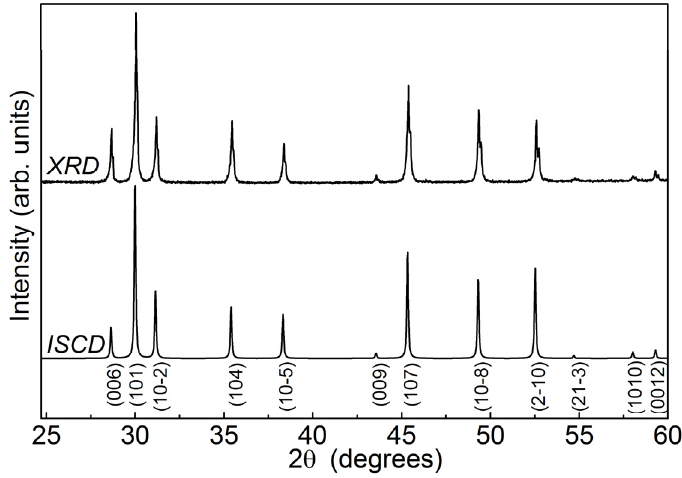
Figure 1. Powder diffraction pattern of the synthesized CuCrS 2 sample (XRD) and reference data (ICSD). Table 1. Sample treatment conditions.